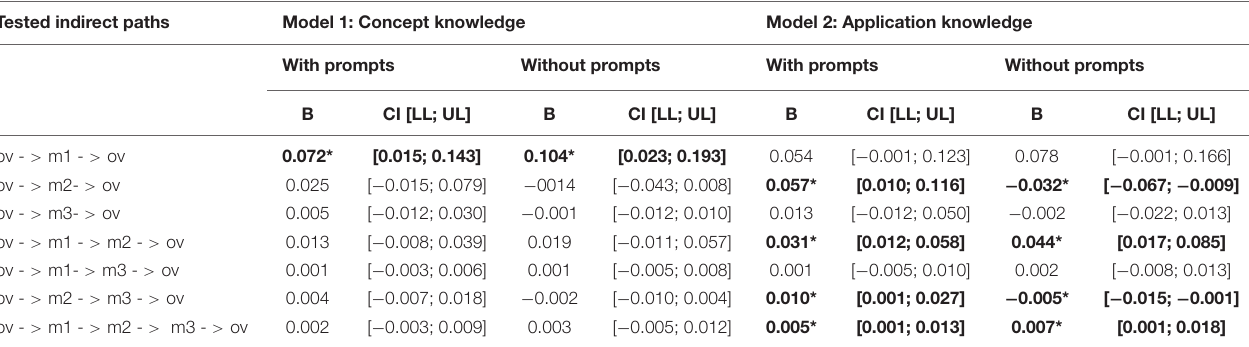
TABLE 7 | Indirect effects for the moderated serial mediation models regarding learning outcomes for the groups with and without prompts: B-coefficients and 95% confidence intervals (CI). Tested indirect